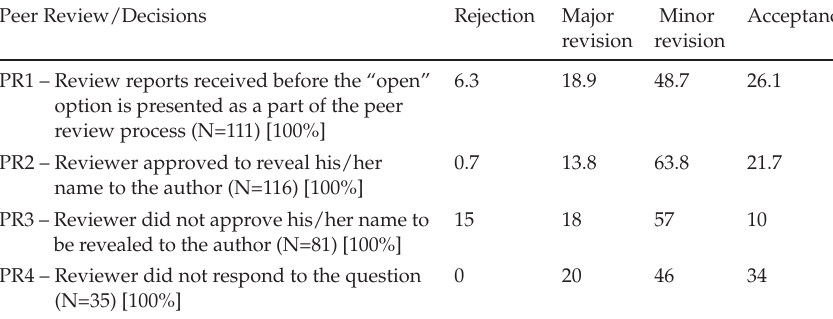
Table 14: Decisions of reviewers regarding each group of peer review